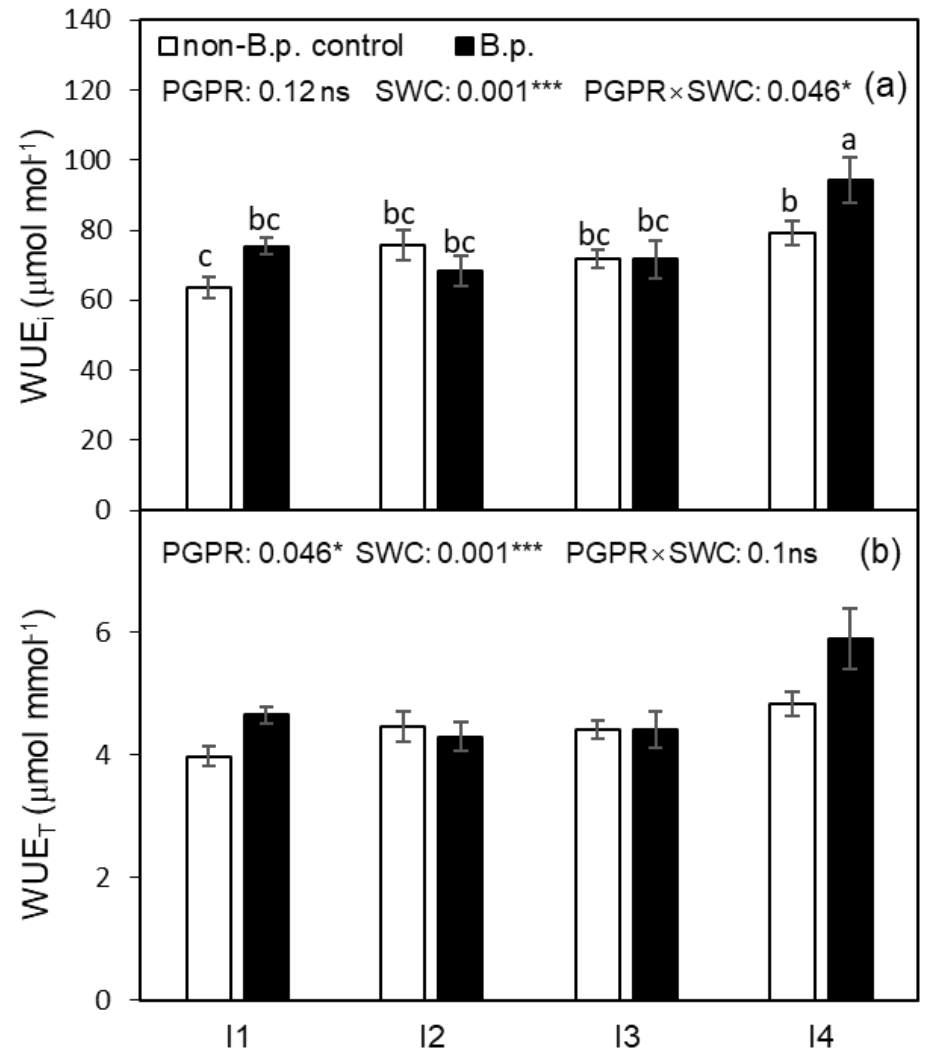
Figure 2. Intrinsic water use efficiency (WUE i ) and instantaneous water use efficiency (WUE T ) of tomato leaf as affected by PGPR inoculation under four irrigation regimes. Different letters indicate a significant difference among treatments based on a Tukey’s honestly significant different test after Two-way ANOVA. Error bars indicate the standard error of the means (SE), n = 4. ( a , b ) in the figure are corresponding to WUE i , and WUE T , respectively. ns indicates the effect was not statistically significant at p < 0.05 level; * and *** indicate significance levels at p < 0.05 and p < 0.001,